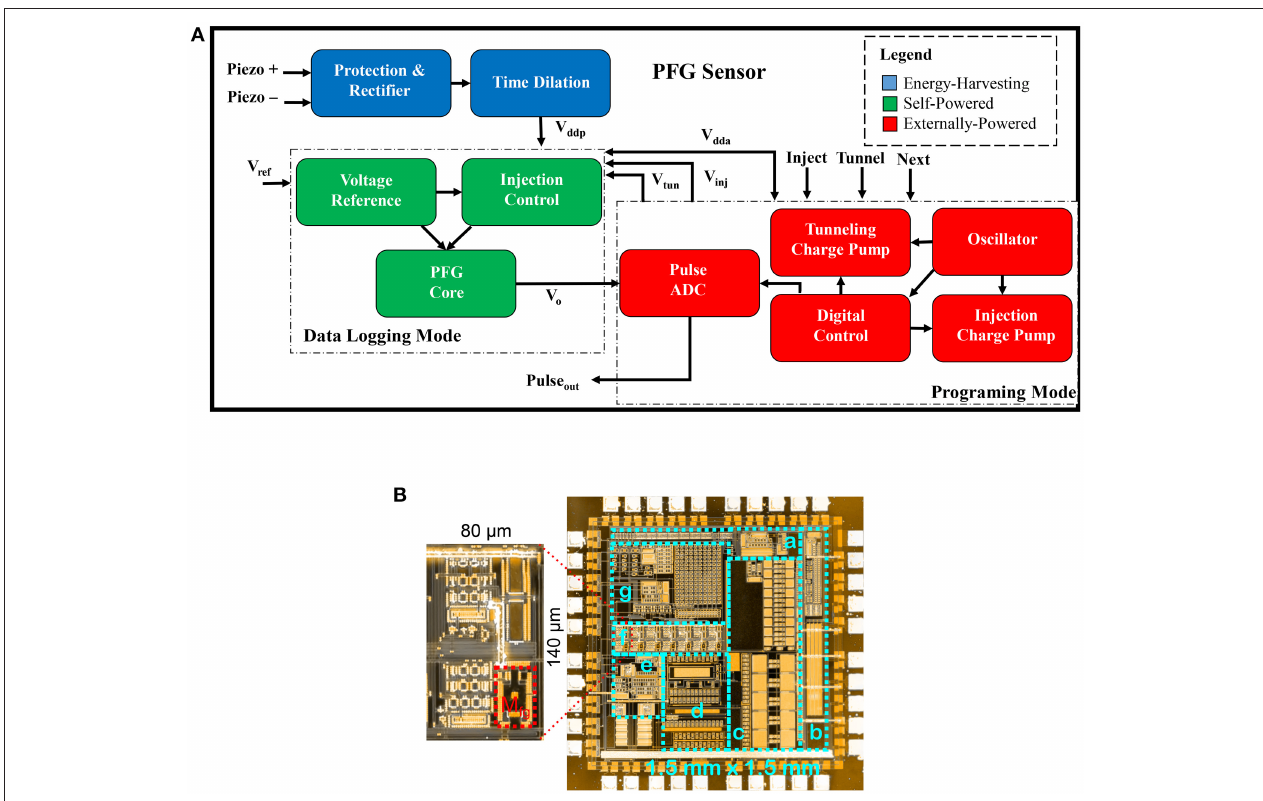
FIGURE 2 | (A) Block diagram of PFG and (B) custom fabricated System-on-Chip micrograph. (A) A high-level overview of the components in a PFG sensor. (B) a. Digital Control, b. Oscillator, c. Charge Pumps, d. Protection, Rectifier, and Time Dilation, e. Pulse ADC, f. PFG Core, g. Voltage Reference and Injection Control. Zoomed inset shows a single channel of the PFG, with the floating-gate highlighted in